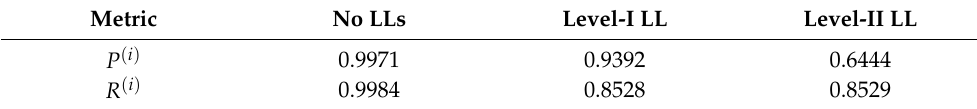
Table 1. Precision and recall of 𝑀 ((cid:2869)(cid:2874),(cid:2874)(cid:2868)(cid:2868)) model.